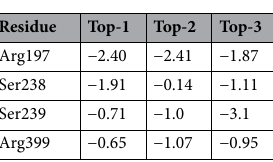
Table 2. Mutated residues binding energy score in